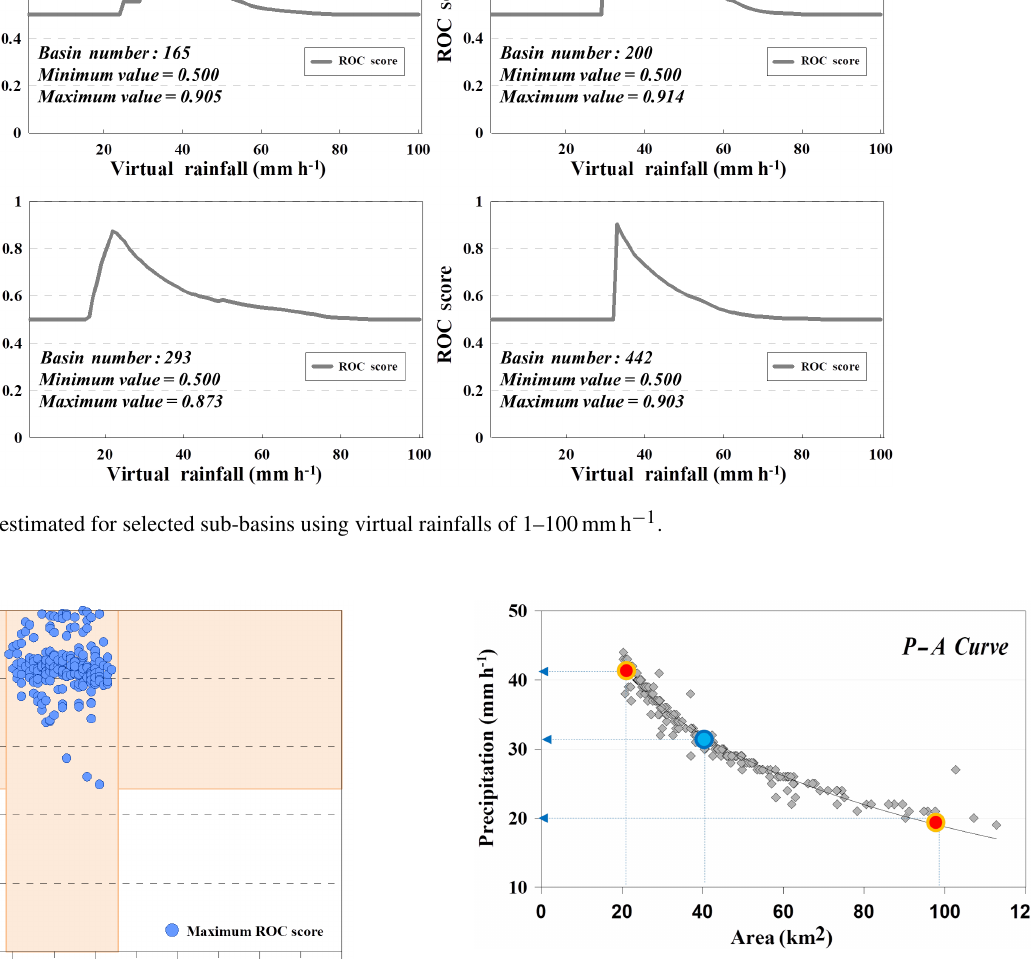
Figure 10. Derived QPC curve for quantitative flash flood condi- tions. Circles represent the categories of criteria according to basin